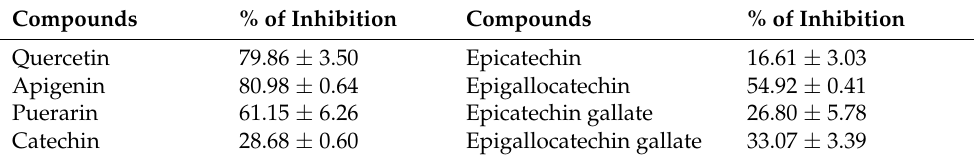
Table 1. The percentage of inhibition of eight flavonoid compounds on XOD@PDA@HF. Compounds